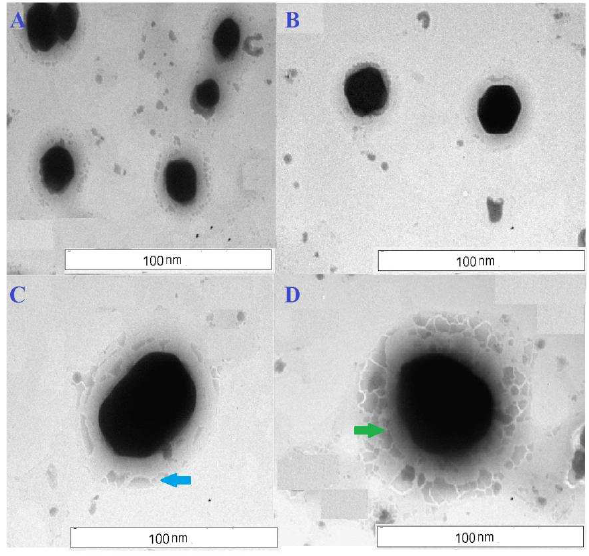
Figure 2. TEM images of ( A ) and ( C ) tamoxifen citrate loaded nanolipid vesicles; light peripheral demarcation indicates the phospholipid bilayer (shown by sky blue arrow). ( B ) and ( D ) antibody conjugated tamoxifen citrate-phosphoethanolamine nanolipid vesicles; the presence of antibody with phosphoethanolamine tagging in phospholipid bilayer revealed darker, thicker, polygonal particulate matters (shown by green arrow).